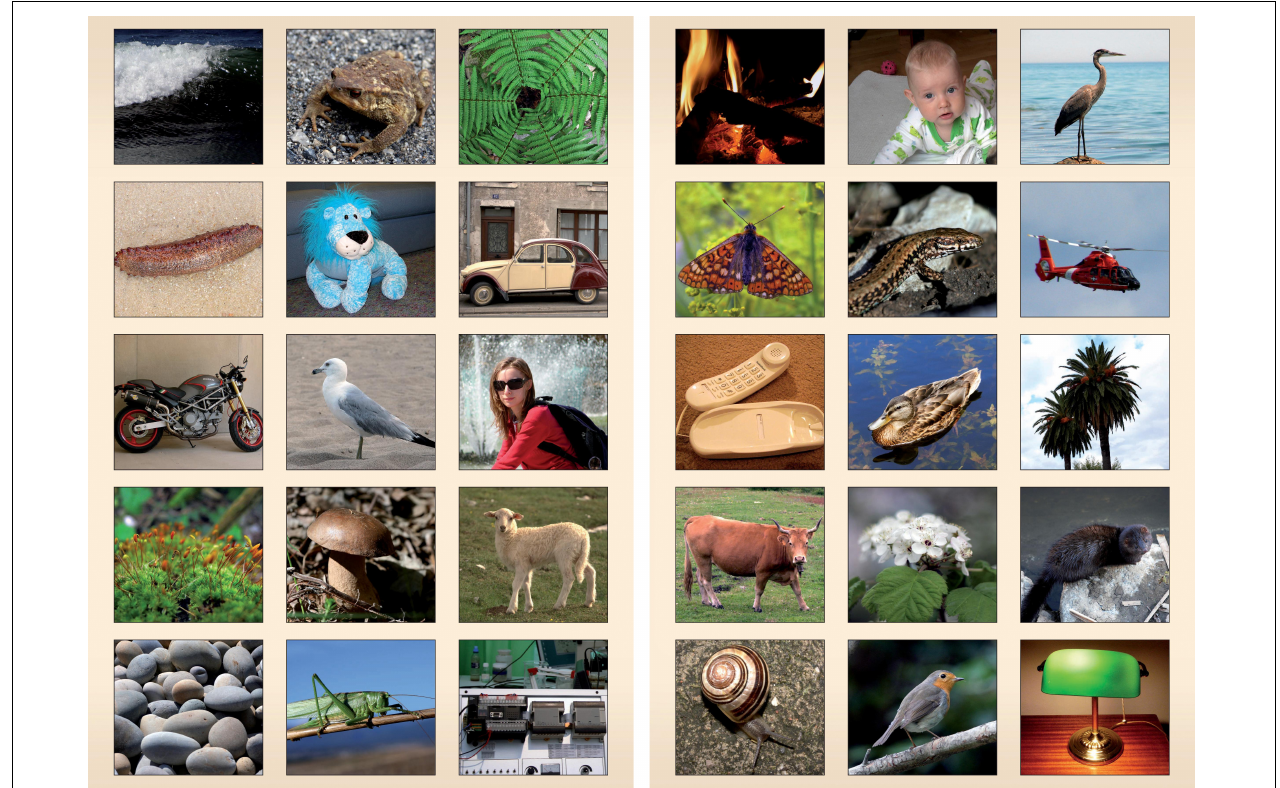
FIGURE 1 | The display presenting 30 target items featured in the induction probe.